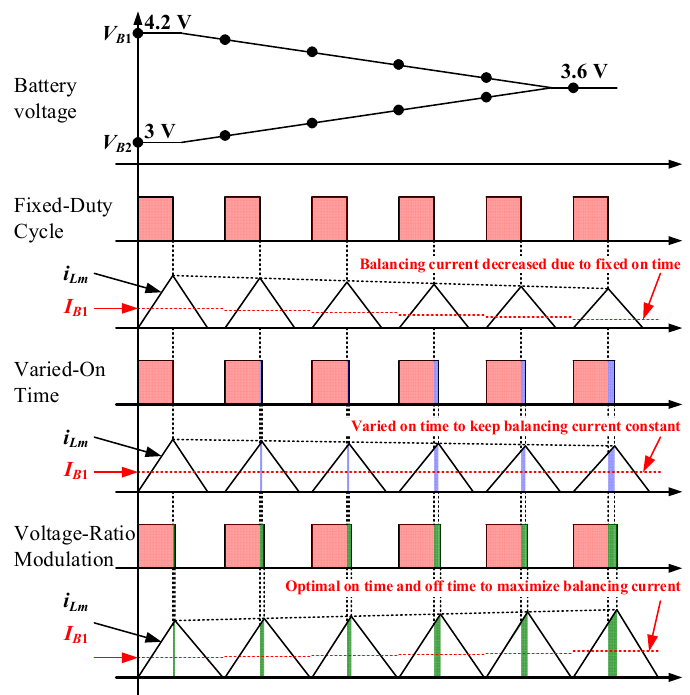
Figure 4. Comparison diagram of balancing current control strategies.